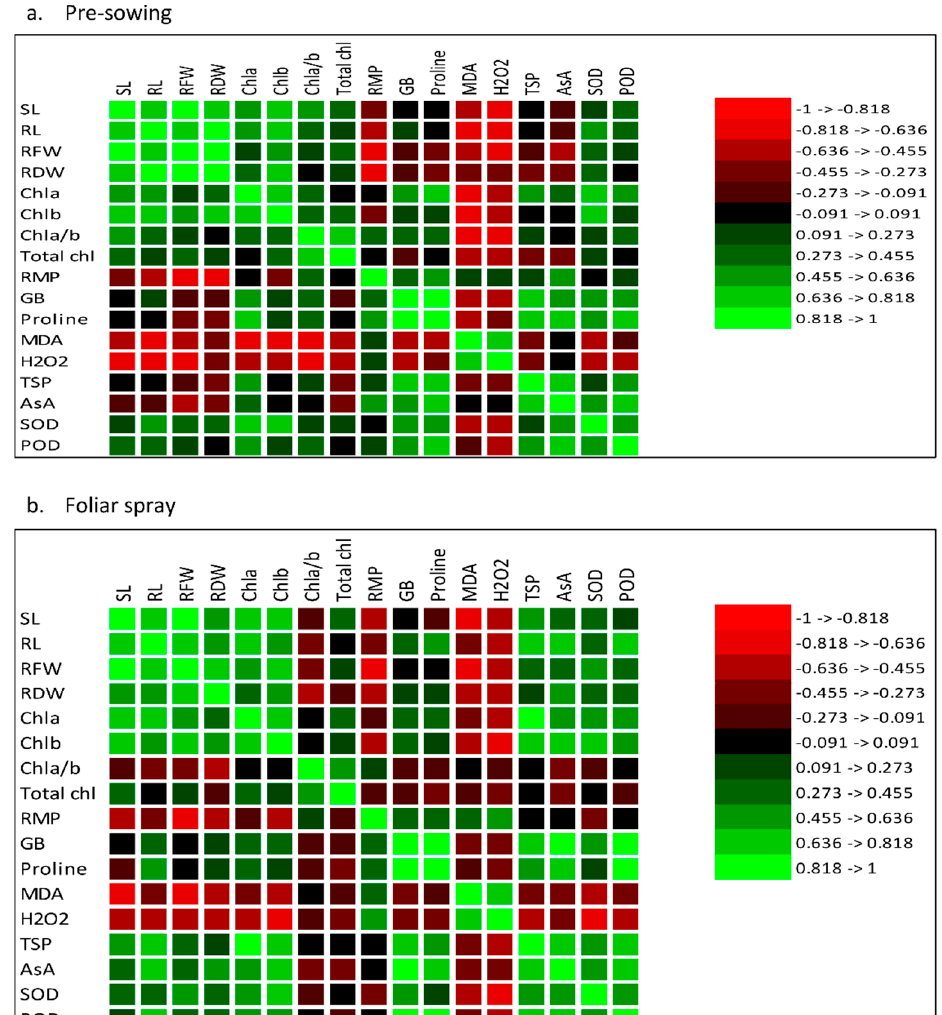
Figure 7. Correlation analysis among different attributes of eggplants subjected to exogenous (( a ) pre-sowing (PS) and ( b ) foliar spray (FS)) application of TOC under water deficit conditions (50% FC) and control (100% FC) ( n = 4).